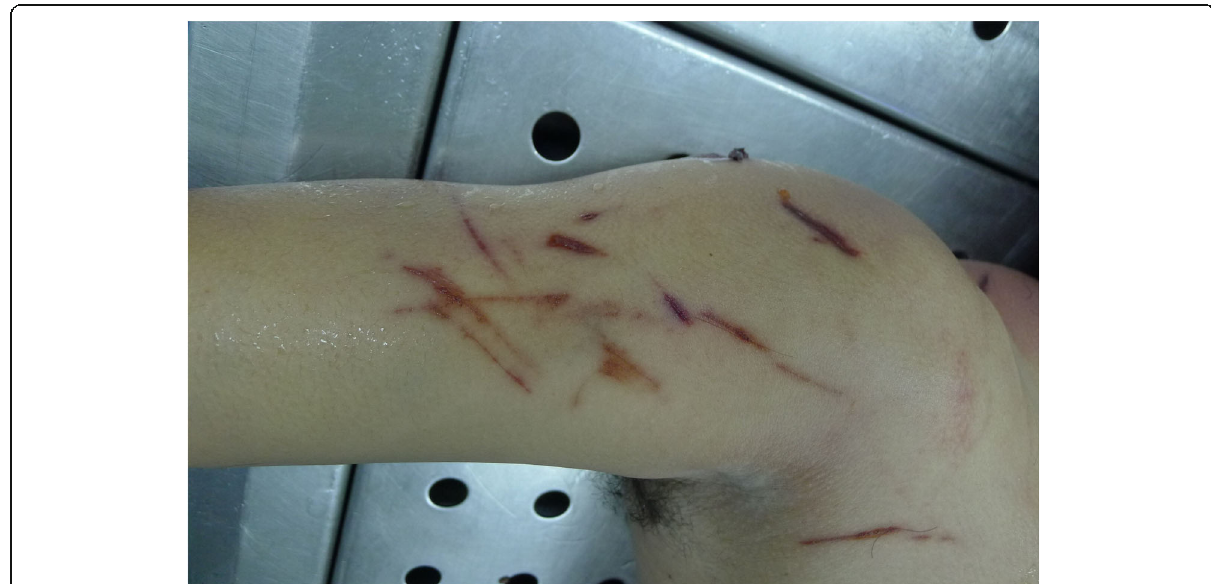
Fig. 7 Multiple groups of shallow abrasions were found on the right